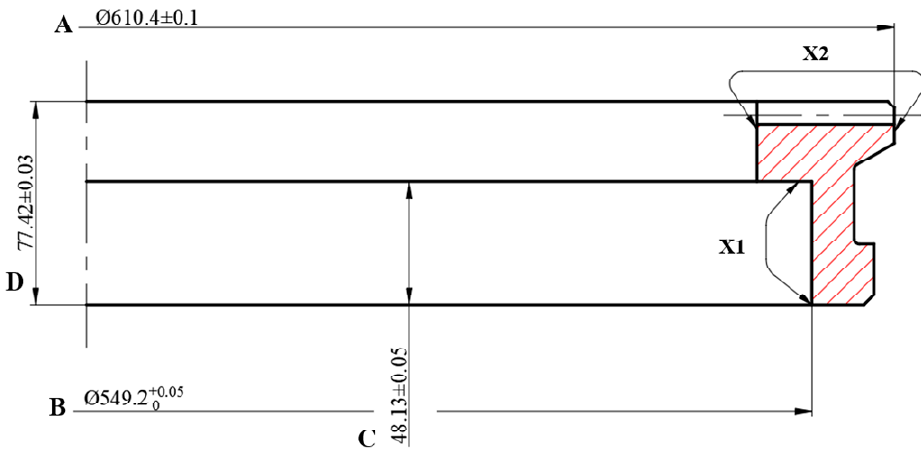
Figure 13. Measurement position of the face gear deformation (X1, X2: Carburizing area).